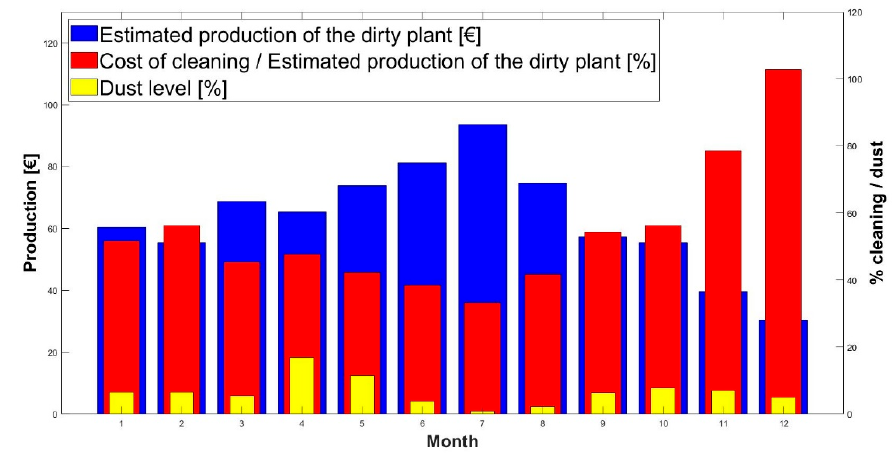
Figure 17. Representation of the minimum percentage of dust required to make cleaning the CIESOL plant profitable (9 kWp).